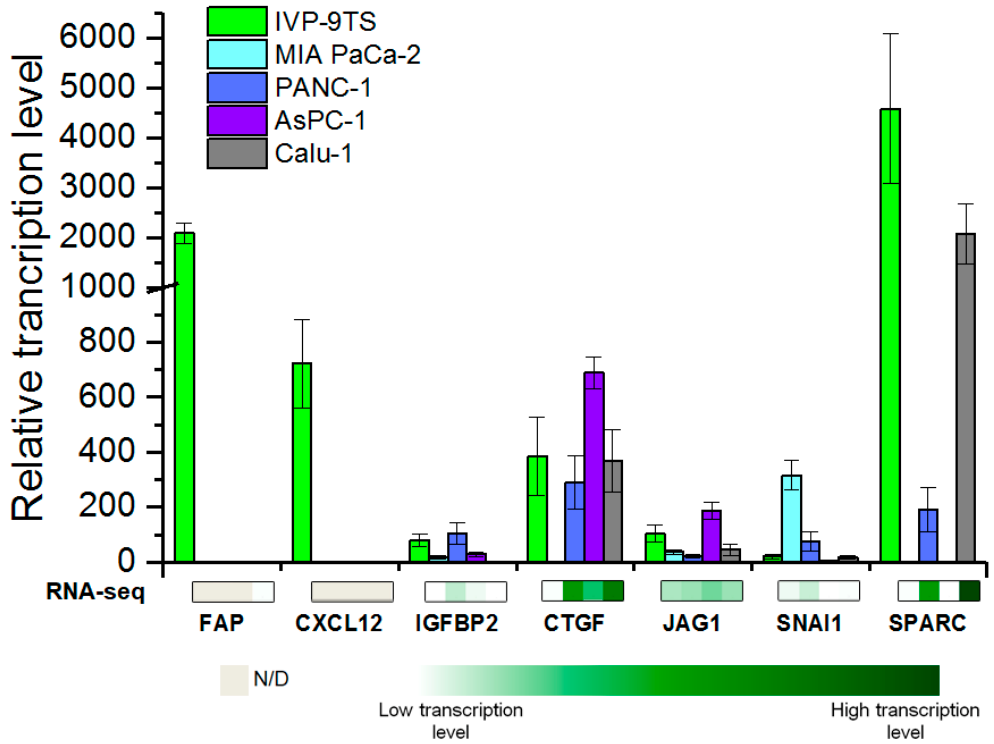
Figure 1. Determination of Transcription Level of selected genes in human cells. The Y-axis indicates the relative level of mRNA content in cells. The values obtained were normalized to the transcription levels of the 18S RNA. The measurements were performed in three independent experiments for each sample and are represented as mean ± s.e.m. The Y-axis serif designate scale break. Below the graph is a heat map of the expression values (in TPM, Transcripts Per Kilobase Million) of the genes in the studied cell lines according to the RNA-seq E-MTAB-2706 database. The names of genes are indicated below the heat map. N/D—no data available.